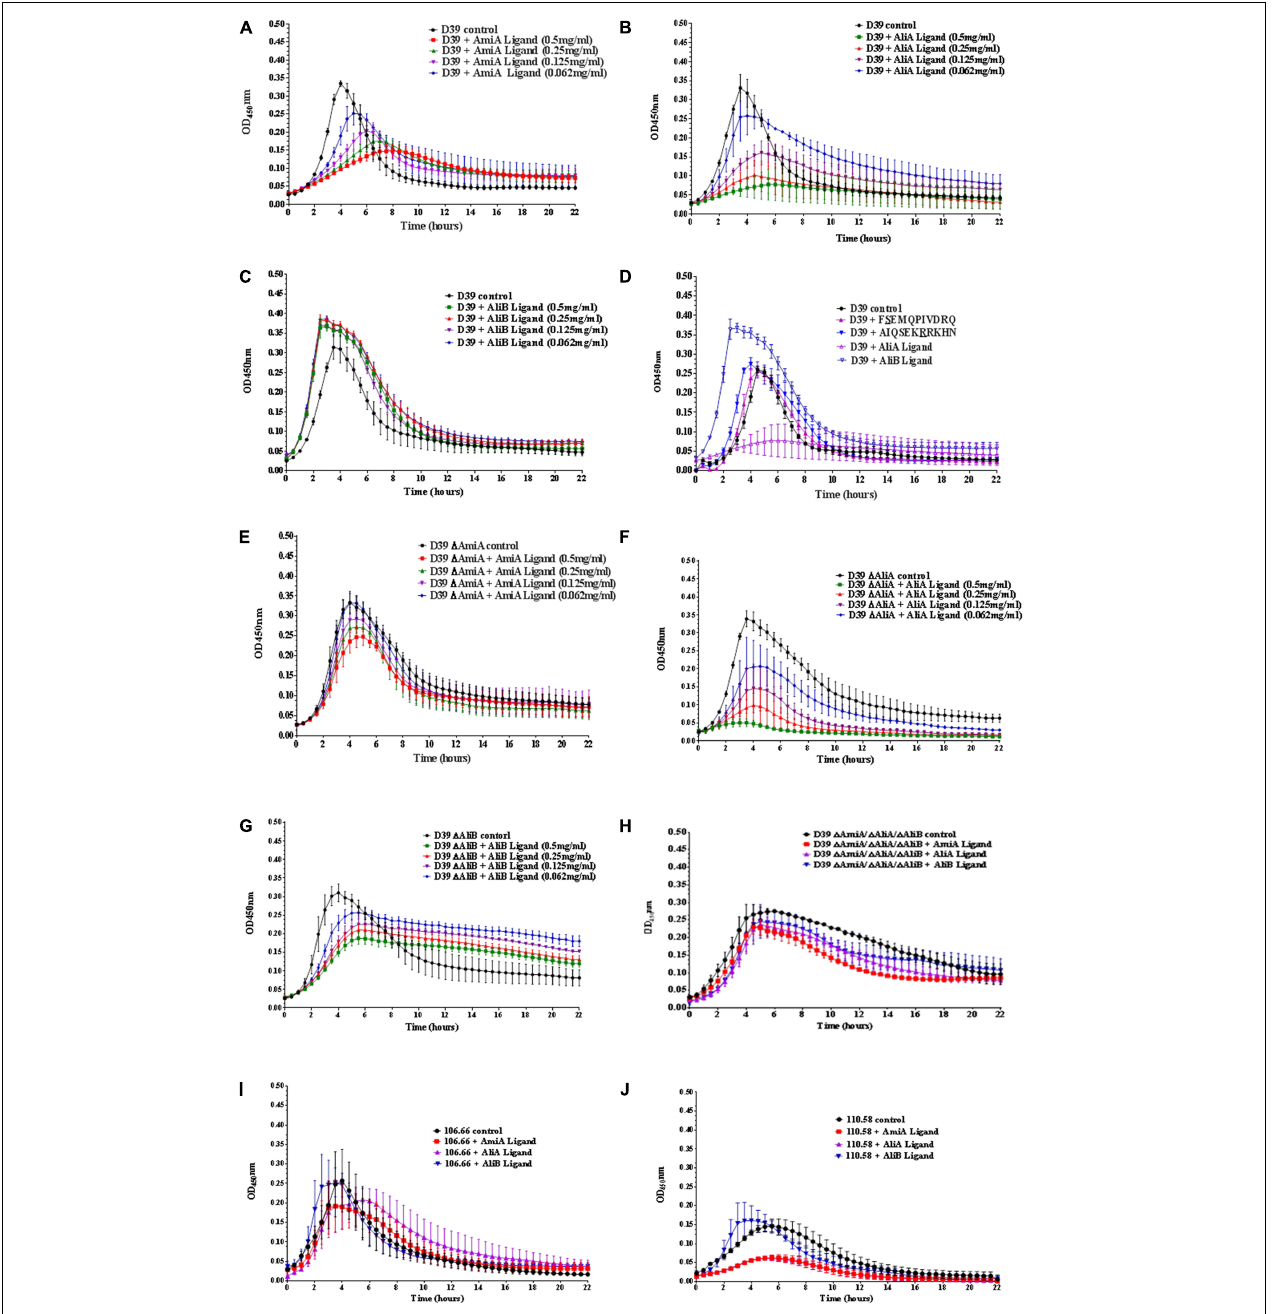
FIGURE 1 | Growth curves of pneumococcal strain D39, its mutants and strains 106.66 and 110.58 in the presence and absence of the peptide ligands of AmiA, AliA, and AliB. Growth in chemically defined medium (CDM) was determined by measuring optical density over time for (A) wild type strain D39 in the absence (control) and presence of AmiA peptide ligand (at the different concentrations indicated), (B) D39 in the absence and presence of AliA ligand, (C) D39 in the absence and presence of AliB ligand, showing that AmiA and AliA ligands cause significant and dose dependent suppression of growth but AliB ligand does not. The effects of peptides on growth were specific as shown in panel (D) where D39 was grown in the absence and presence (0.5 mg/mL) of peptides with a single amino acid substitution: FSEMQPIVDRQ differs from AliA ligand at the second amino acid and AIQSEKRRKHN differs from AliB ligand at the seventh amino acid (underlined). Growth curves in the presence of the unmodified ligands have been included to allow direct comparison. AmiA peptide had much less suppressive effect on growth of the mutant lacking the AmiA receptor, D39 (cid:49) AmiA (E) . Whereas growth of the D39 (cid:49) AliA mutant was suppressed by AliA peptide (F) . Unlike the wild type D39 strain, growth of the D39 (cid:49) AliB mutant was reduced by the AliB peptide (G) . None of the three peptide ligands had a great effect on the triple mutant (cid:49) AmiA/ (cid:49) AliA/ (cid:49) AliB ( H ). Suppression of growth by AmiA and AliA peptides but not AliB peptide was also seen in two clinical pneumococcal isolates: strain 106.66 (serotype 6B) (I) and non-encapsulated strain 110.58 (J) (Peptide concentrations of 0.5 mg/mL). Curves show the mean values of at least three independent experiments performed on different days, error bars equal SEM.